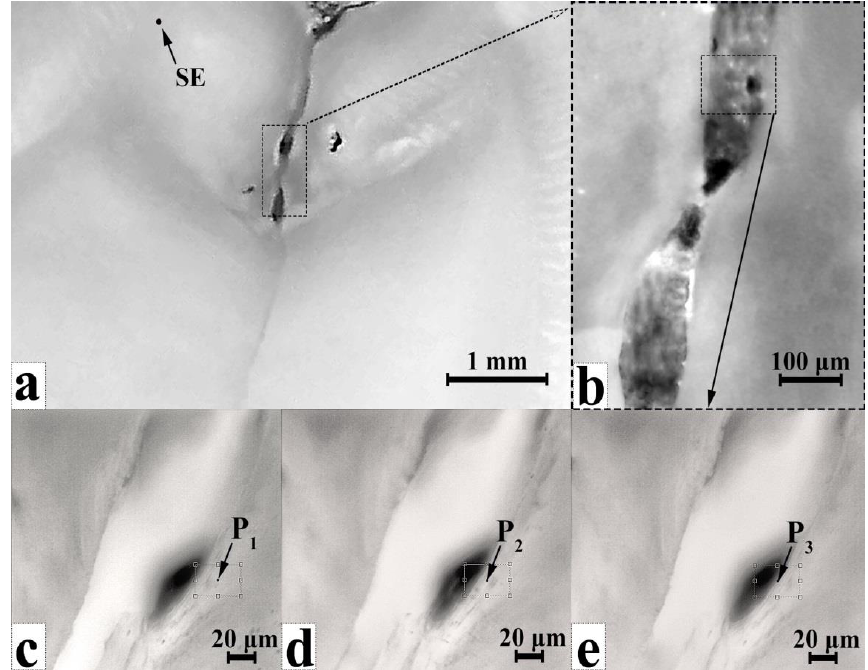
Figure 4. Optical images of regions of sample E with incipient caries (ICDAS 1): ( а ) 8× magnification; ( b ) area of the carious cavity in the enamel, 130× magnification; ( с – e ) images of microregions in the carious region involving microcavities, showing microRaman scanning points (200× magnification). The typical microRaman scattering spectra with the fluorescence background ob- tained from the regions containing sound enamel (region SE in Figure 4a) and different regions of the enamel with incipient caries at 10, 5 and 0.5 μm from the edge of the cavity